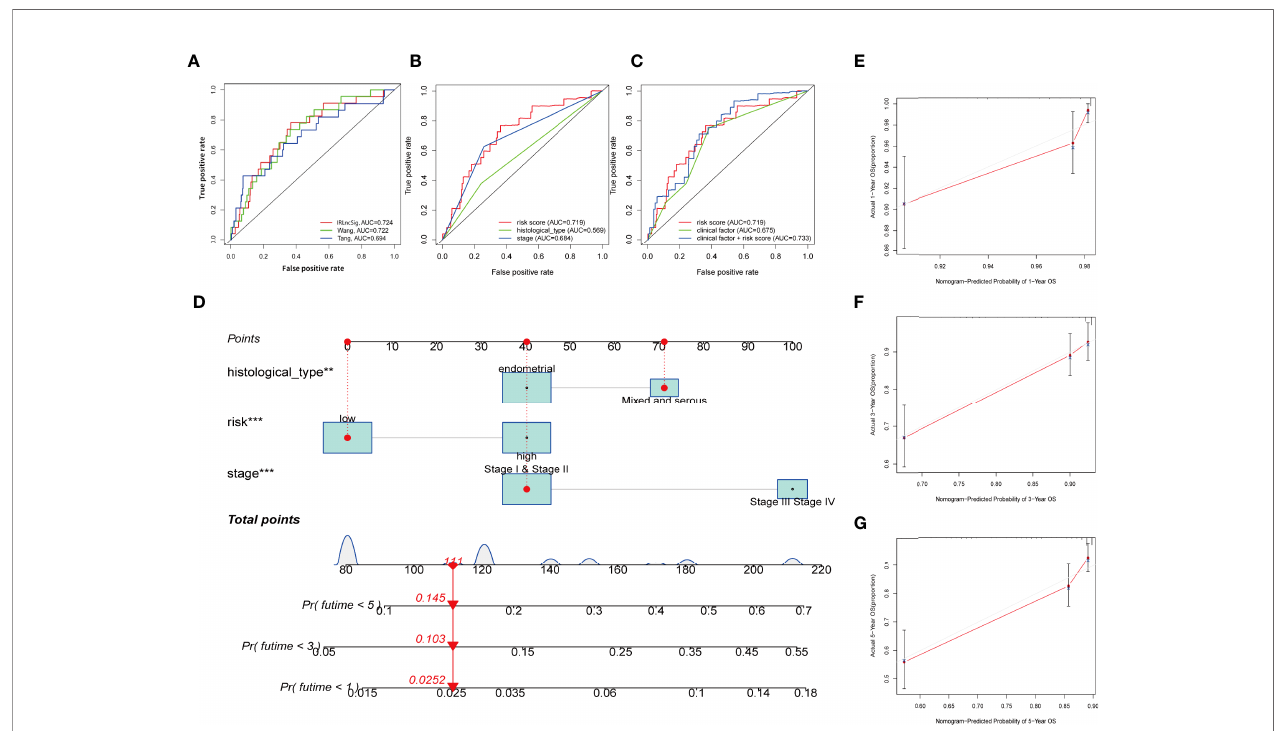
FIGURE 6 | Establishing the IRLPS based on risk score and clinical factors, and validating it in calibration plot. (A) ROC plot indicates that IRLPS is superior in predicting the prognosis in UCEC patients than previous works. (B) IRLPS is also more superior in prediction accuracy than histological type or tumor stage alone. (C) Combining IRLPS with clinical factors is better yet. (D) A nomogram to illustrate the IRLPS, a risk model to predict endometrial carcinoma patient prognosis basing on aforementioned IRLPS, and clinical factors. (E – G) Calibration curves showing the favorable performance of nomogram. **P < 0.01 ***P <